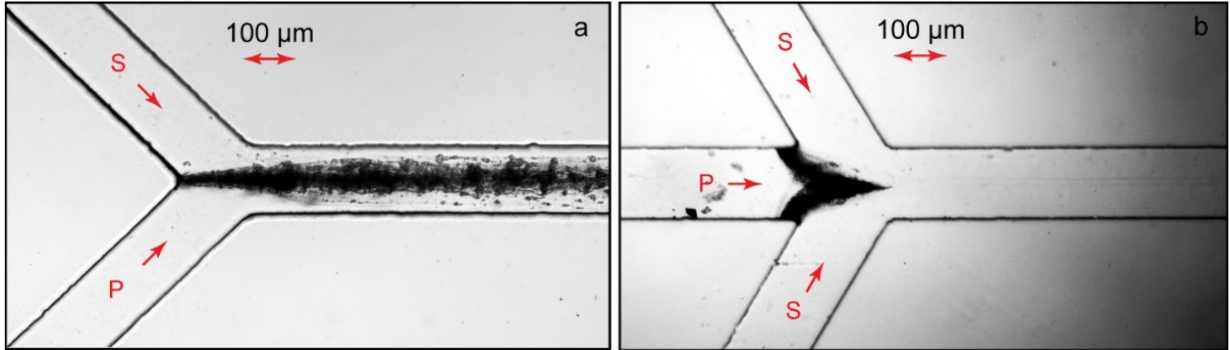
Figure 2. Microfluidic synthesis of PAA ‐ CTAB complexes (Z = 1) in contacting flows of a Y ‐ junction chip ( a ) and via flow focusing ( b ). P—polyelectrolyte, S—surfactant. Polyelectrolyte flow rates are 10 μ L/min ( a ) and 1 μ L/min ( b ). Surfactant flow rates are 10 μ L/min. Chip lengths L = 15 mm and widths W = 200 μ m. Duration of the experiments: 15 min.